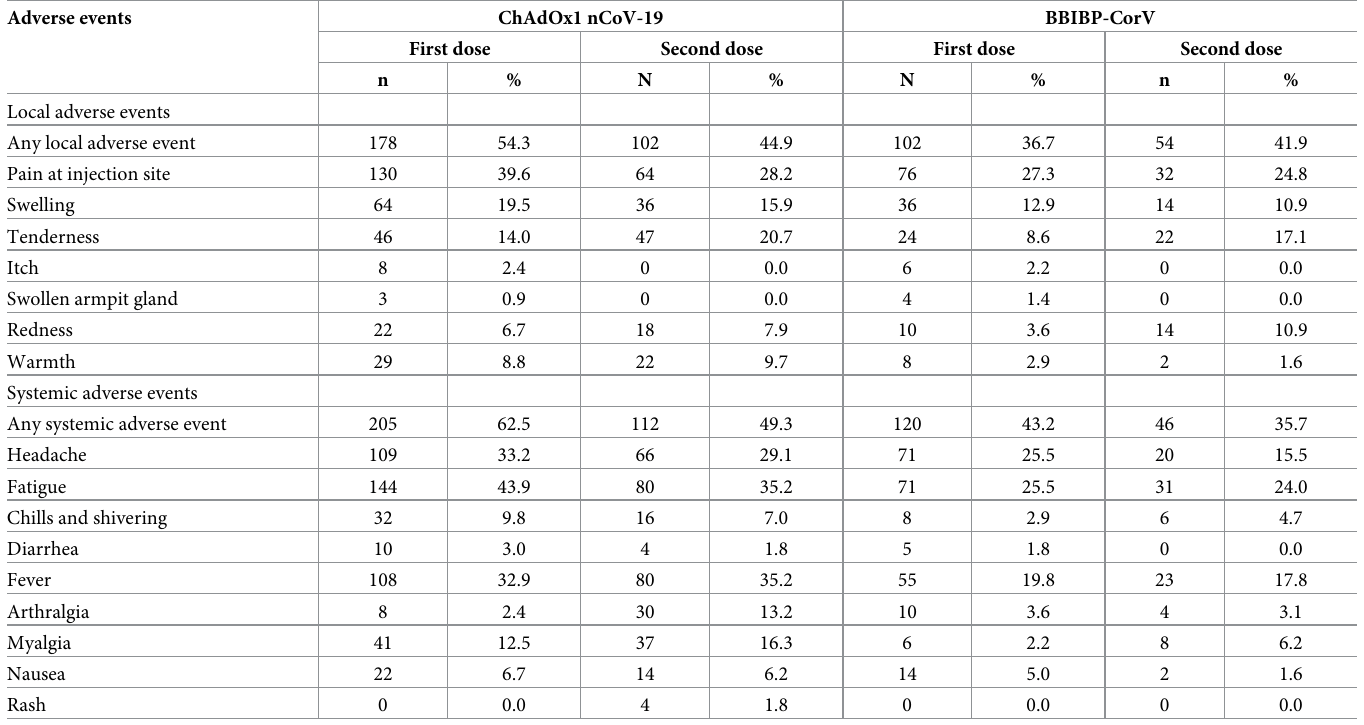
Table 2. Adverse events reported by the participants after vaccination (n =